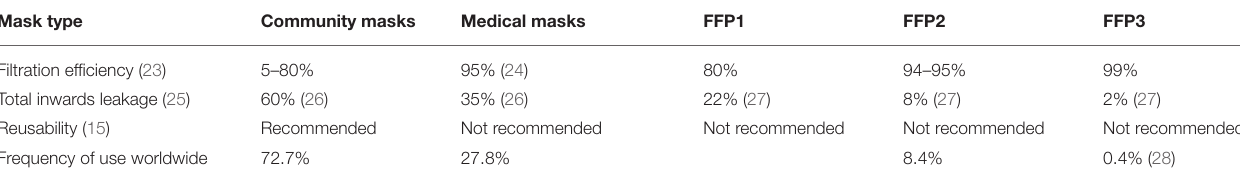
TABLE 1 | Effectiveness level, reusability, global use of different masks (before September